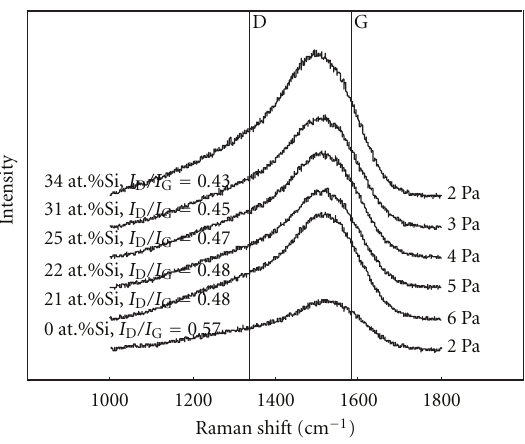
Figure 2: Raman spectra of DLC-Si–O films before annealing (as deposited).